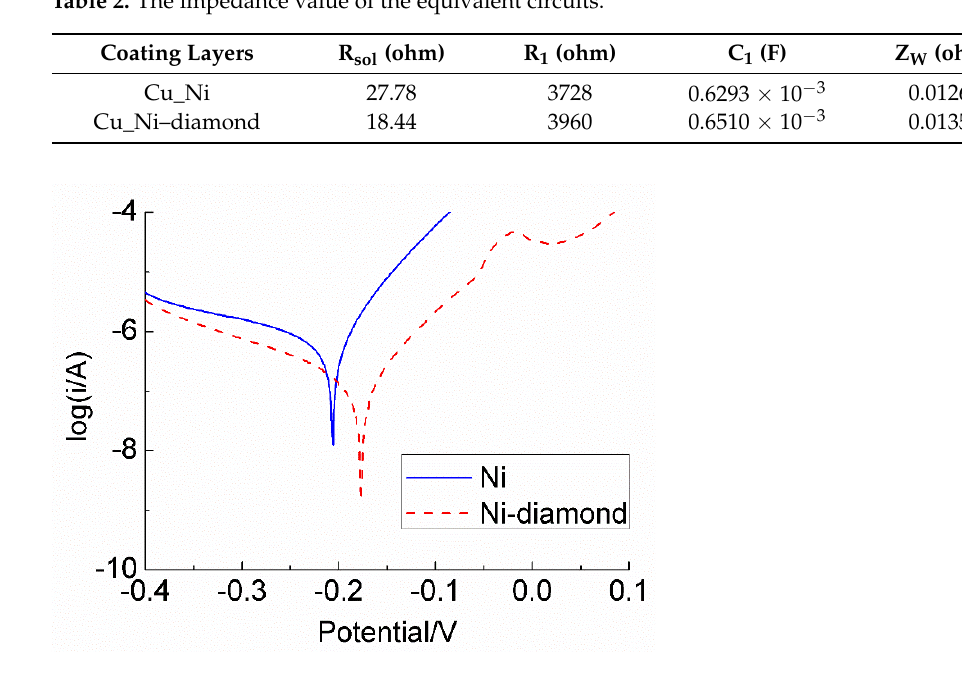
Figure 11. The Tafel curves of the Ni coating and the Ni–diamond coating.